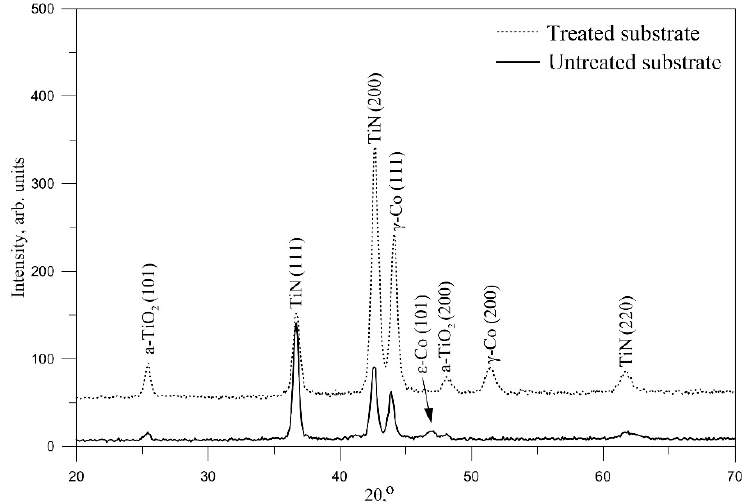
Figure2. XRDpatternofthedepositedcoatingsonelectronbeam-treatedanduntreatedCo–Crsubstrate. Figure 2. XRD pattern of the deposited coatings on electron beam-treated and untreated Co–Cr substrate. Table 1. The shares of microvolumes of di ff erent texture components evaluated by P hkl . Substrate